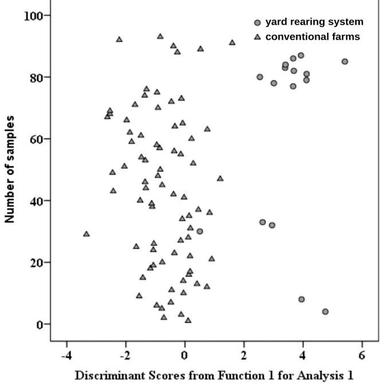
Meat samples distribution based on δ13C, Rb, As, Re, Sb, Ga, Ce, La and Zn variables, according to animal diet, after applying LDA.